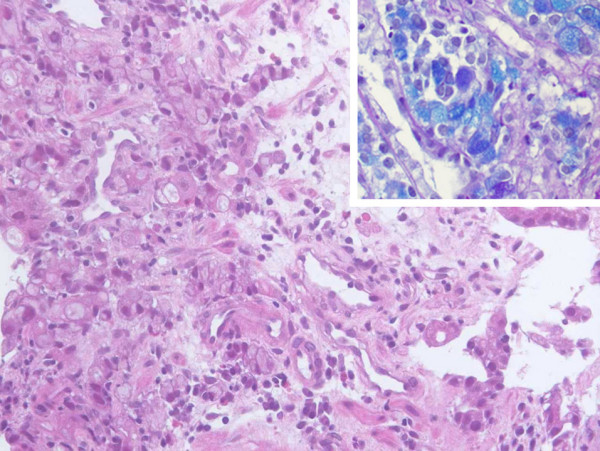
Gastric biopsies revealed an undifferentiated signet-ring cell gastric carcinoma (hematoxylin and eosin stain, ×400). Note the characteristic distribution of blue intracytoplasmic mucines in the neoplastic cells (inset) (Alcian-Pas stain, ×400).